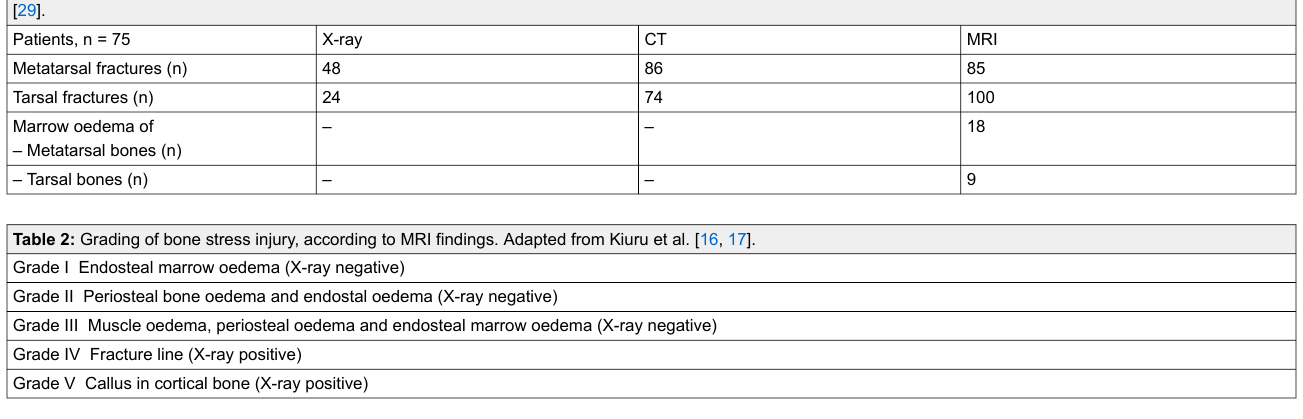
Table 1: Skeletal pathology in patients with acute sprain, as shown by X-ray and simultaneous computed tomography (CT) and magnetic resonance imaging (MRI) scan [29]. Patients, n = 75